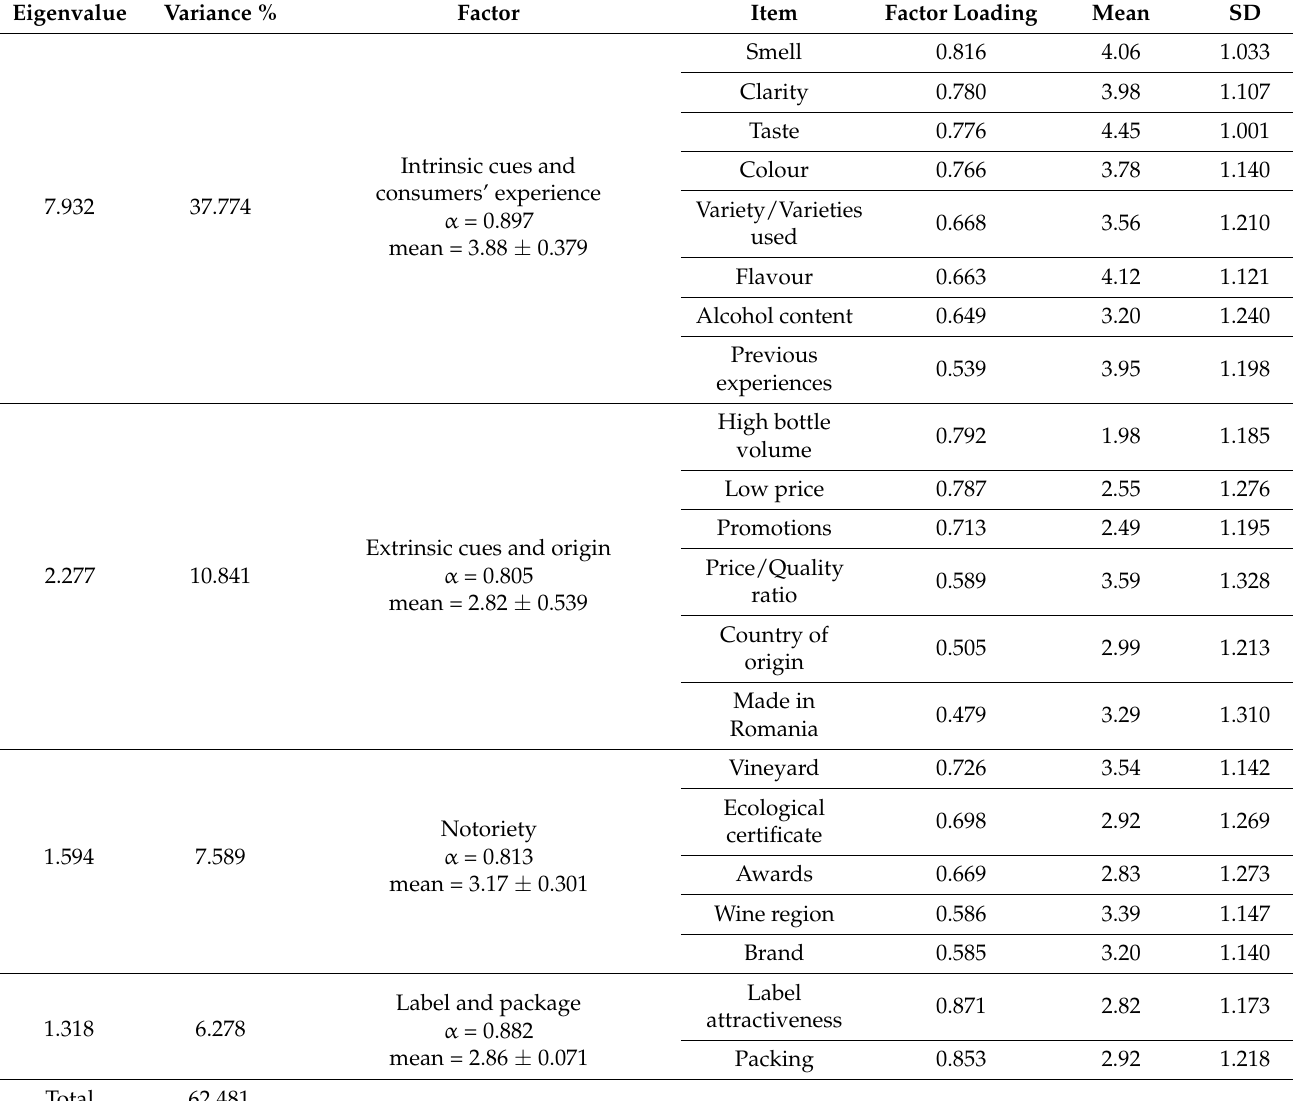
Table 2. Principal component analysis on wine